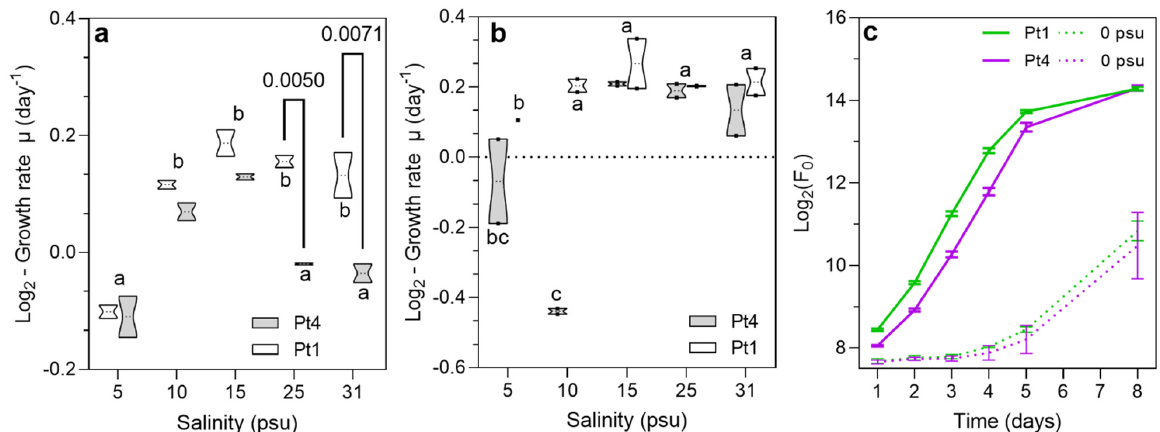
Figure 1. Characterization of growth of P. tricornutum strains Pt1 and Pt4 in synthetic media at 0, 5, 10, 15, 25 and 31 psu based on cellular autofluorescence (F 0 ) as a proxy for biomass. ( a ) Box plot showing minimum, maximum, and mean values (dotted line) of growth rates in Pt1 and Pt4 during trial 1 at all salinity levels except 0 psu. Letters ‘a’ and ‘b’ denote significant different groups (adj. p < 0.01) determined by a two-way ANOVA post hoc multiple comparisons between all group combinations. The adj. p -value is provided for the significant intra-strain differences at 25 and 31 psu. ( b ) Box plot as in ( a ) for the trial 2 (after additional acclimation to the respective media) ( c ) Growth curves of both strains from data in ( a , b ). Error bars represent SD values around the mean. Full lines represent samples of all salinity conditions except 0 psu ( n = 8). Dotted lines represent growth in the 0 psu conditions ( n = 2).